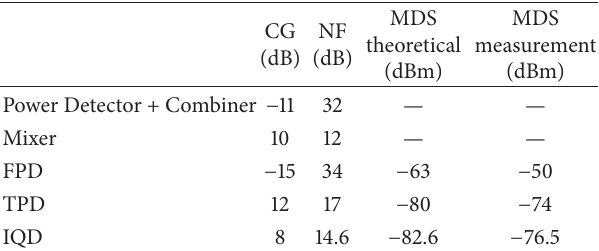
Table 1: Conversion gain (CG), noise figure (NF), and theoretical and measured minimum detectable signal (MDS) for FPD, TPD, and IQD architectures @ 𝑓 = 2.8 GHz for BER = 10 −3 (1Msps 0.35 SQRRC-filtered QPSK modulated RF signal with